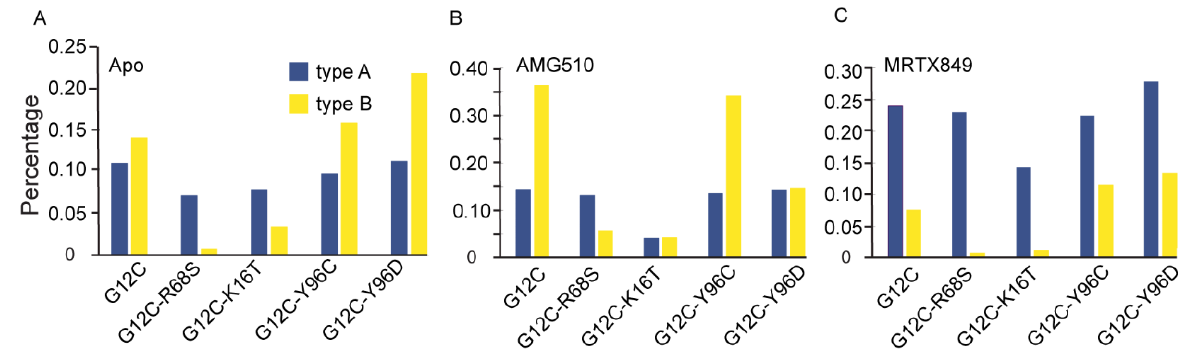
Figure 10. The percentage of two conformational type A and type B in five apo ( A ), five AMG510- bound ( B ), and five MRTX849-bound ( C ) complexes, respectively.